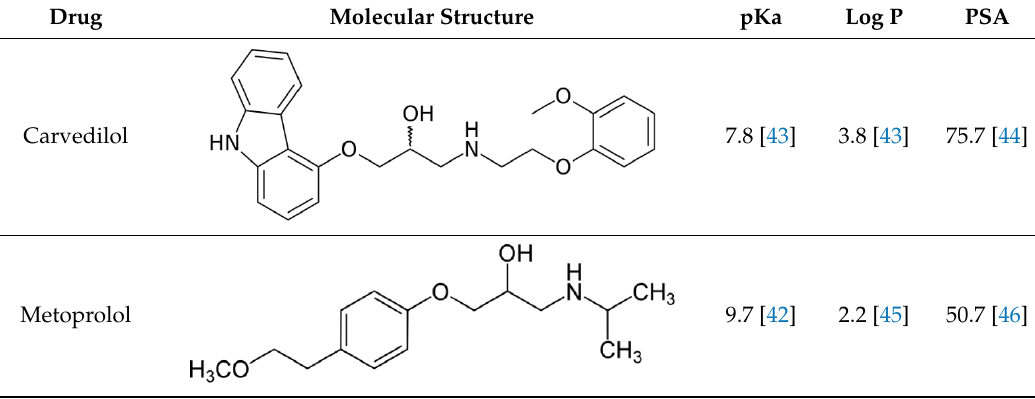
Table 2. Carvedilol and metoprolol molecular structures and relevant physicochemical parameters. Drug